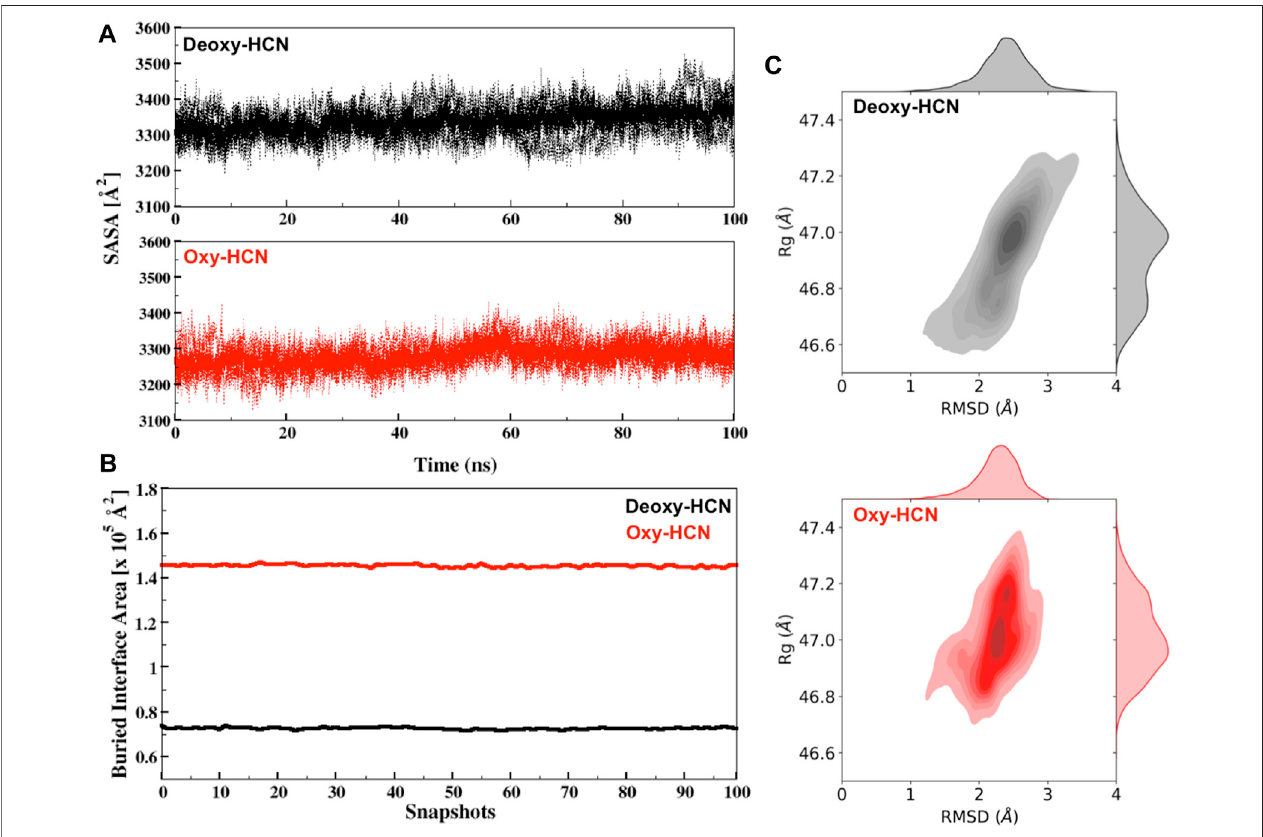
FIGURE 7 | (A) Solvent accessible surface area (SASA) for Deoxy-HCN (black) and Oxy-HCN (red) of all subunits (dashed) and their average (bold). (B) Interface accessible surface area (IASA) buried due to inter-residual contacts for Deoxy-HCN (black) and Oxy-HCN (red) of 100 snapshots extracted from the last 40 ns of each trajectory. (C) The radius of gyration versus C α -RMSD correlation plot for Deoxy-HCN (black) and Oxy-HCN